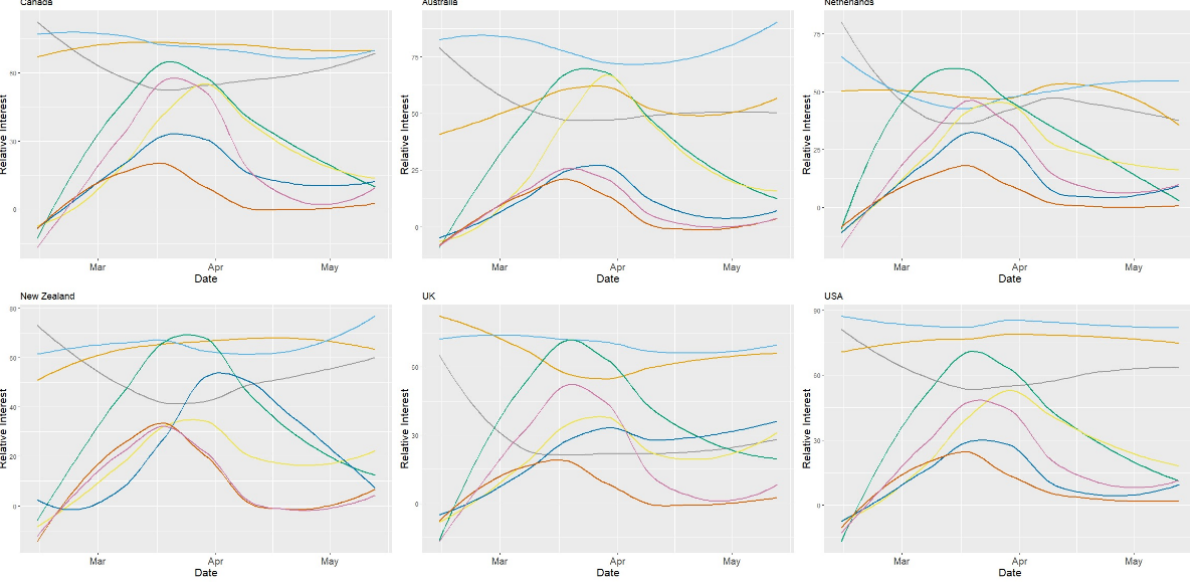
Figure 1. Google Trends data for the selected 6 countries from between February 14, 2020 and May 13, 2020. The grey curve represents the relative interest for the term ‘‘suicide,’’ the orange curve represents the relative interest for the term ‘‘depression,’’ the light blue curve represents the relative interest for the term ‘‘anxiety,’’ the green curve represents the relative interest for the term “Coronavirus (Virus),” the yellow curve represents the relative interest for the term “social distancing,” the dark blue curve represents the relative interest for the term ‘‘lockdown,’’ the red curve represents the relative interest for the term “school closure,” and the purple curve represents the relative interest for the term ‘‘self-isolation." UK: United Kingdom; USA: United States of